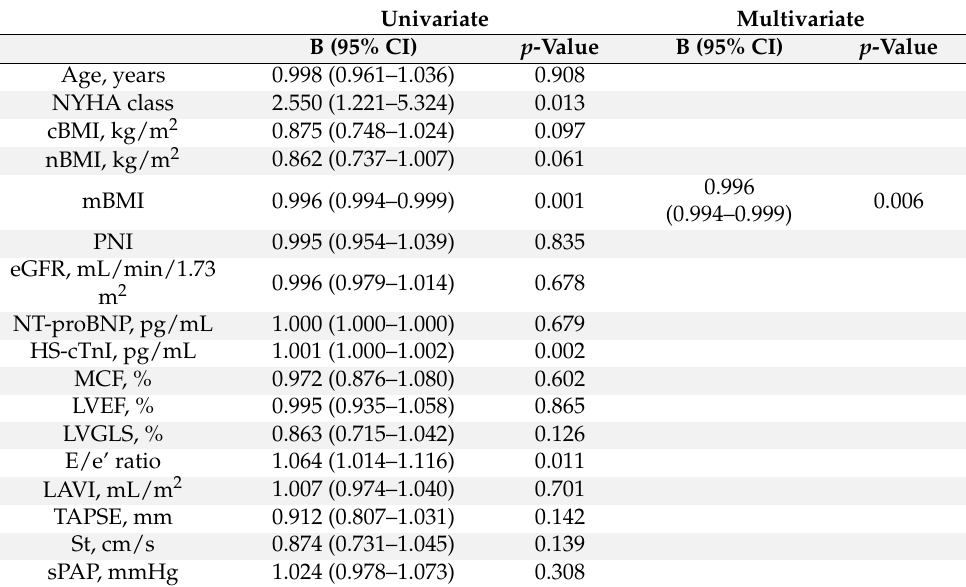
Table 3. Univariate and multivariate regression analysis of the proposed nutritional indices with established clinical, laboratory, and echocardiographic